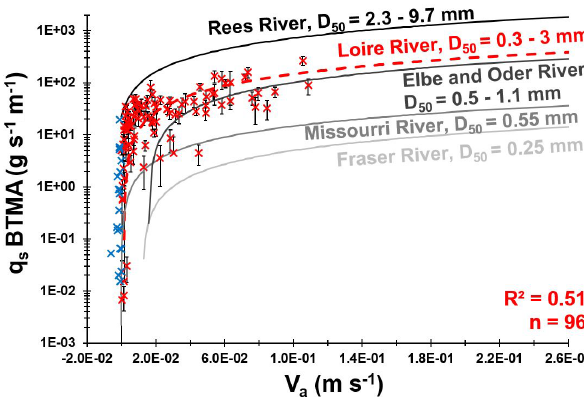
Figure 3. Unit bedload transport rates measured with BTMA sam- plers as a function of the apparent bedload velocity measured with aDcp. The red dashed line represents the RMA regression of the Loire River. Compare with other site-specific calibration curves (Conevski et al., 2020a; Rennie et al., 2017). Blue marks repre- sent negative apparent bedload velocity values excluded from this